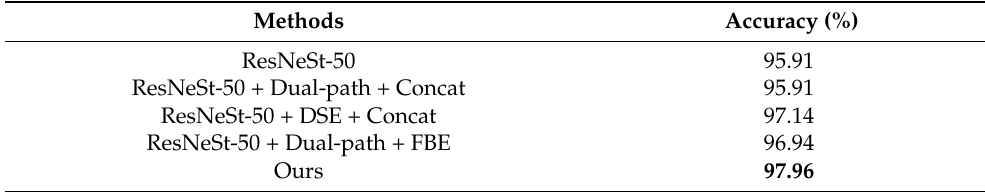
Table 3. Ablation analysis on the dataset BT-4C. Our DSE block and FBE layer provide progressive improvements over the